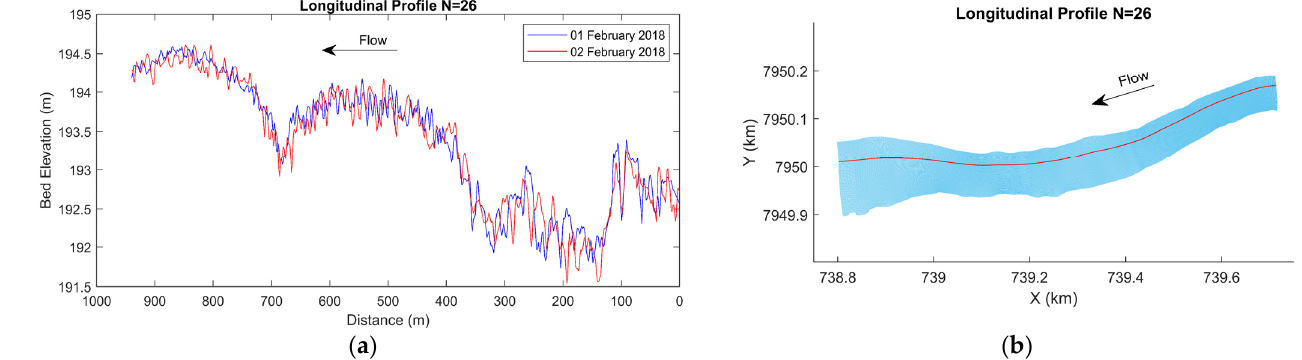
Figure 13. Pair of longitudinal bed profiles (at N = 26) measured at Taquari River. ( a ) Elevation view; ( b ) plan view (grid).